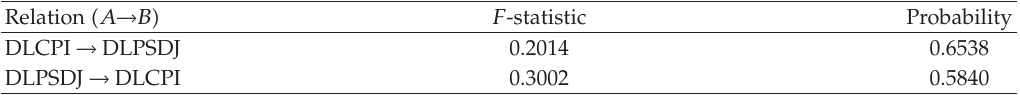
Table 4: Test for nonlinear causality (cid:5) symmetric case (cid:6) . If P > . 05, then at 5% we accept the null hypothesis that A does not cause B . The M-G model parameters were τ 1 (cid:8) τ 2 (cid:8) 1, and c 1 (cid:8) c 2 (cid:8) 2. Relation (cid:5) A → B (cid:6)